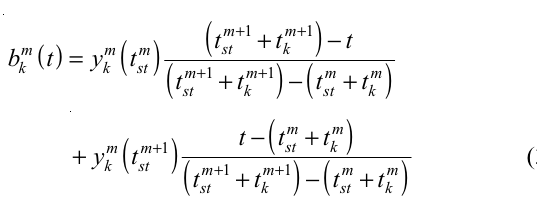
Figure 11 Adaptation of desired